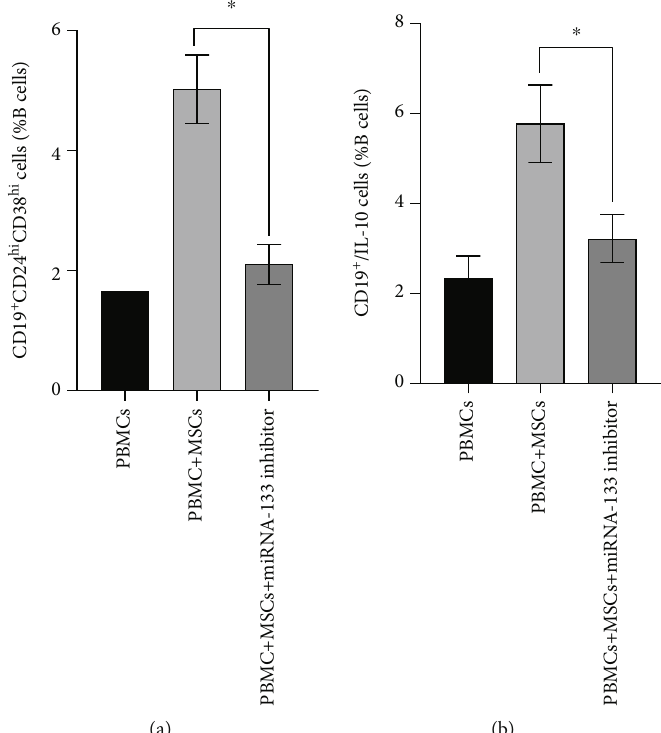
Figure 5: SDF-1 α regulates the e ff ects of MSCs on B cells through changing the miR-133 level. (a) Transfected by miR-133 inhibitor, the ability of MSCs to facilitate CD19 + CD24 hi CD38 hi CD19 + B cells was depressed. (b) Transfected by miR-133 inhibitor, the ability of MSCs to facilitate IL-10-producing CD19 + B cells was depressed. ∗ P < 0 : 05